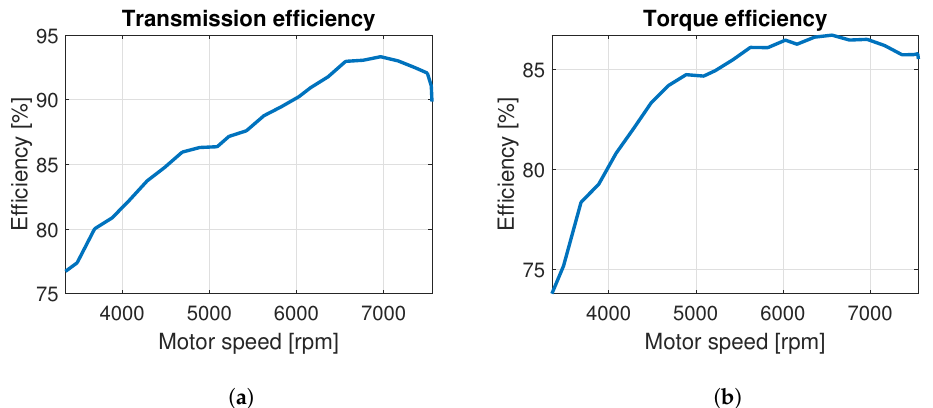
Figure 7. Result of efficiency curves based on speed: ( a ) Energy efficiency of the gearbox transmission and ( b ) Torque efficiency of the mechanical